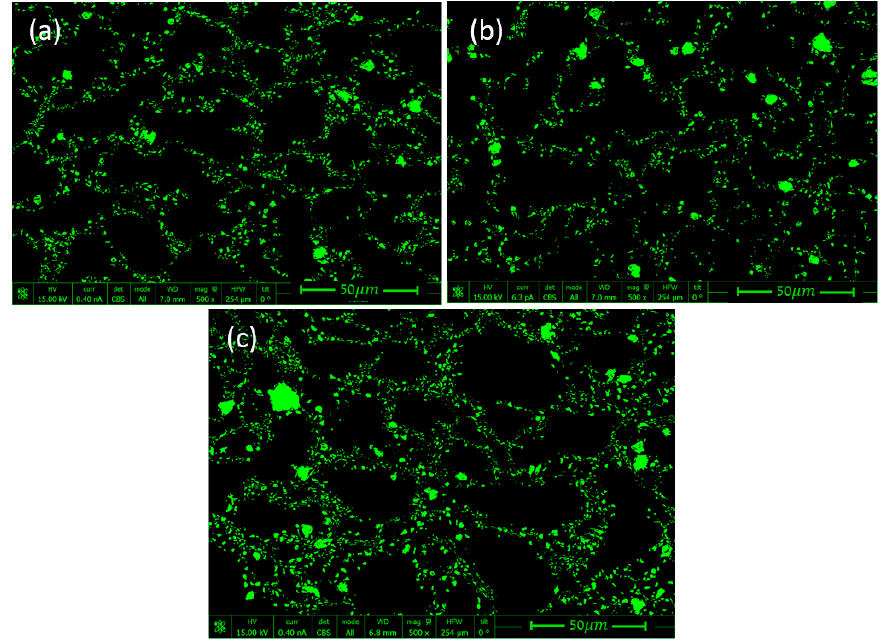
Figure 4. SEM micrographs of Al–TiB 2 fabricated by SPS: ( a ) 5%, ( b ) 10%, and ( c ) 15% vol of TiB 2 particles [22].